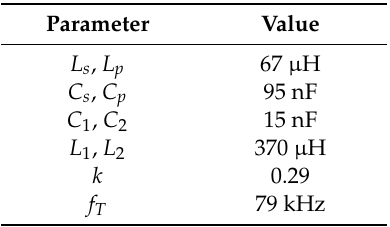
Table 3. Experimental parameters.